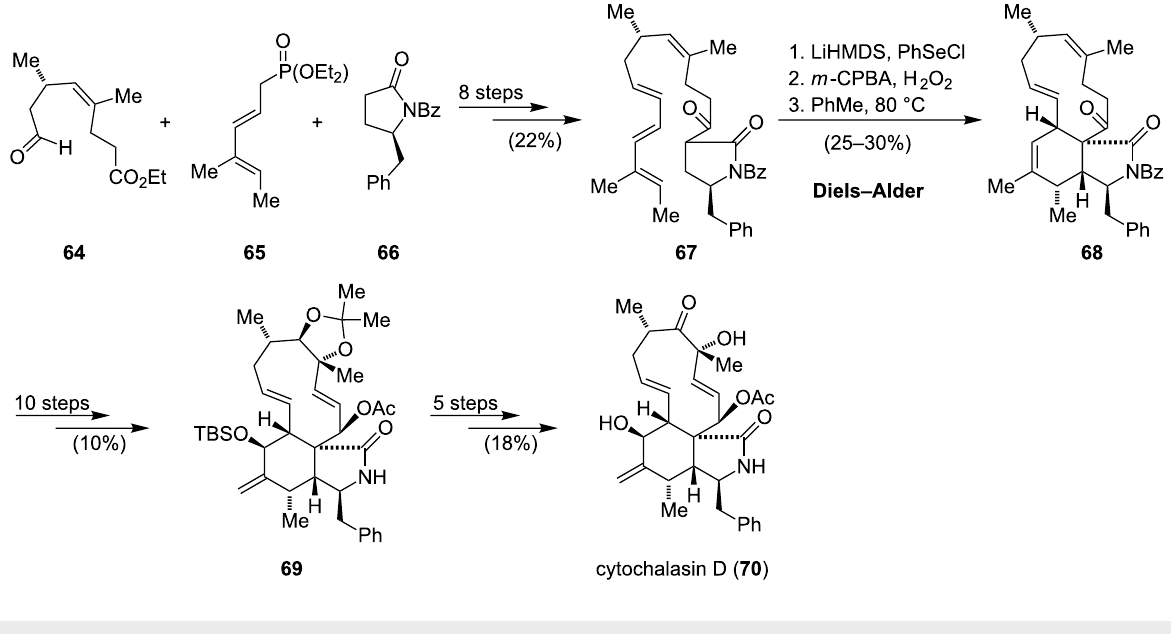
Scheme 7: Synthesis of cytochalasin D ( 70 ) by Thomas [63].